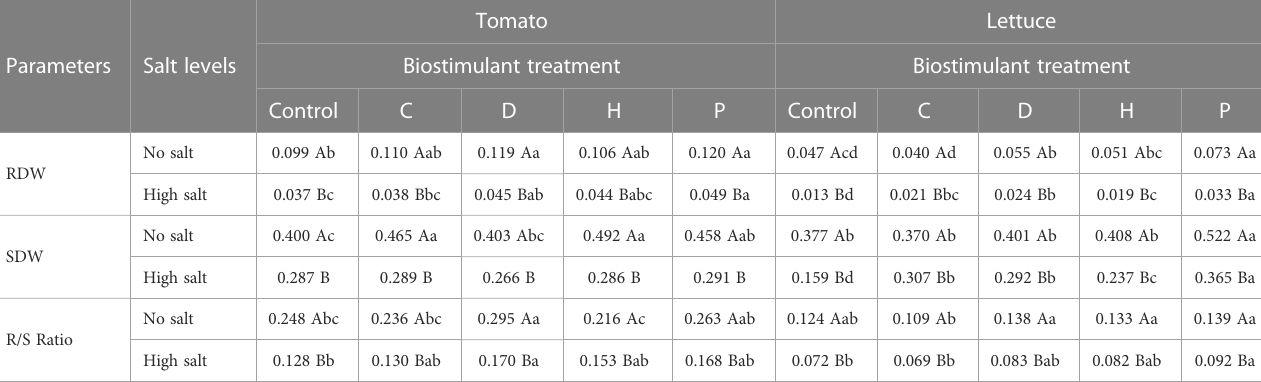
TABLE 1 Root dry weight (RDW), shoot dry weight (SDW) and root to shoot (R/S) ratio of tomato and lettuce grown under salinity stress and protein hydrolysates application.